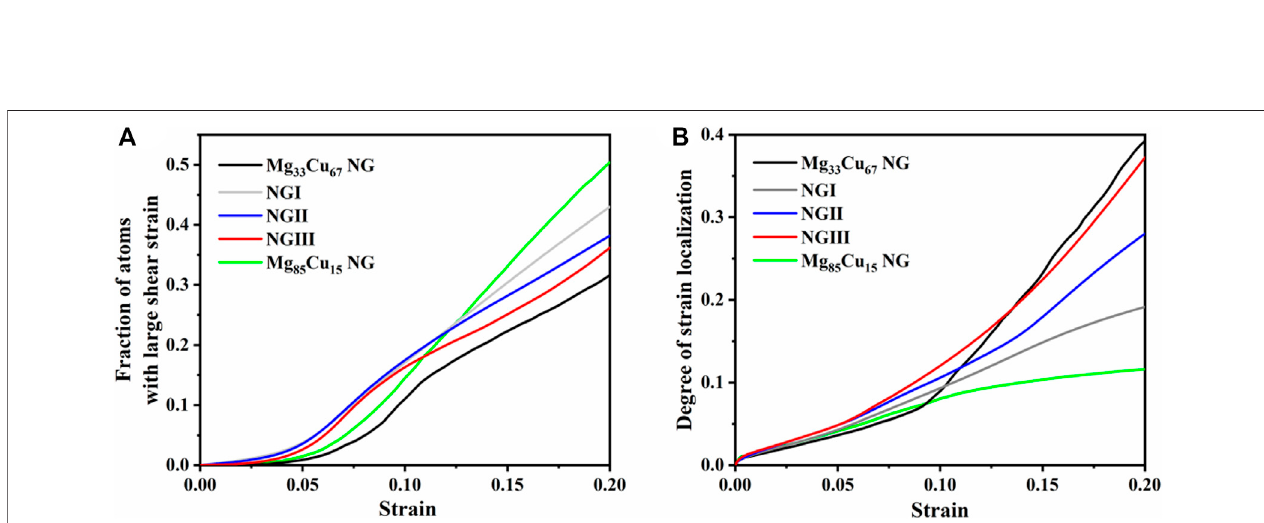
FIGURE8|(A) Thefractionofatoms withlarge η Mises ≥ 0 . 2,and (B) thestrainlocalizationparameter valuesduring deformationforNGI,NGII, and NGIII. Thetrends in the single-phase NGs are also plotted for comparison.